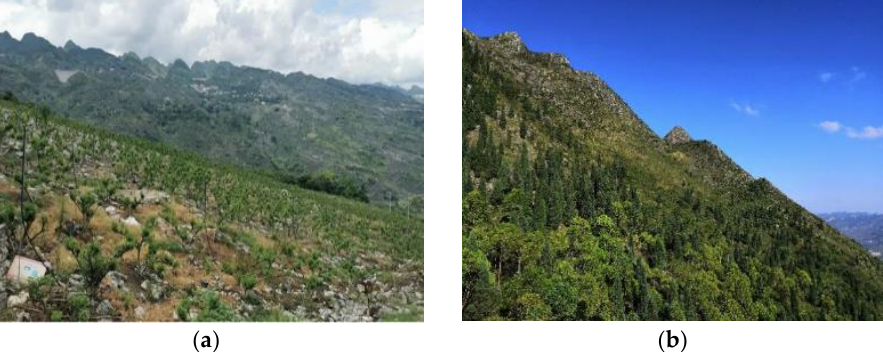
Figure 6. Measures to control rocky desertification: ( a ) artificial afforestation; ( b ) closed mountain afforestation.